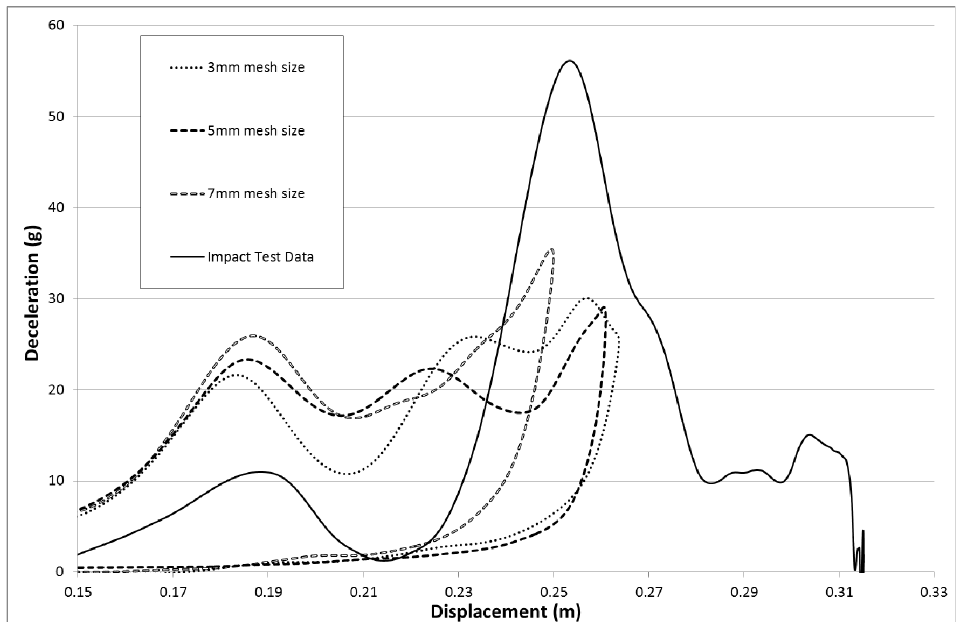
Figure 26. Investigation of mesh sensitivity with three runs using the same model input file with All Slim = 1.0, TSize = 1 × 10 − 8 , Erods = 1.0, Soft = 1.0 and FS = − 1.0.